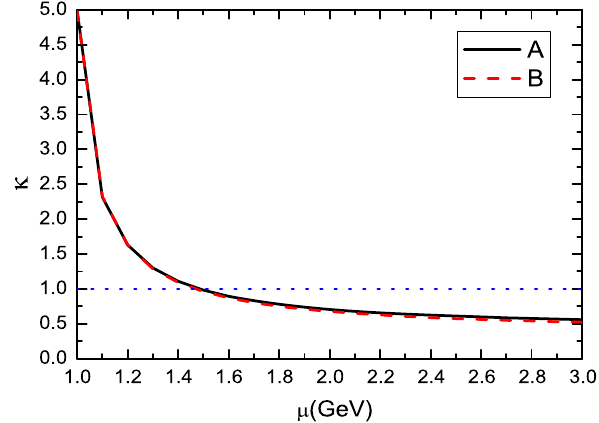
Fig. 6 The coefficient κ with variation of the energy scale μ , where A and B denote the values come from Eqs. (27) and (28), respectively